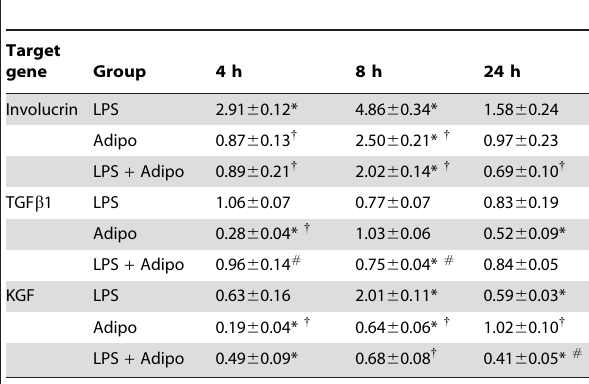
Table 3. Interactions of lipopolysaccharide and adiponectin on involucrin and growth